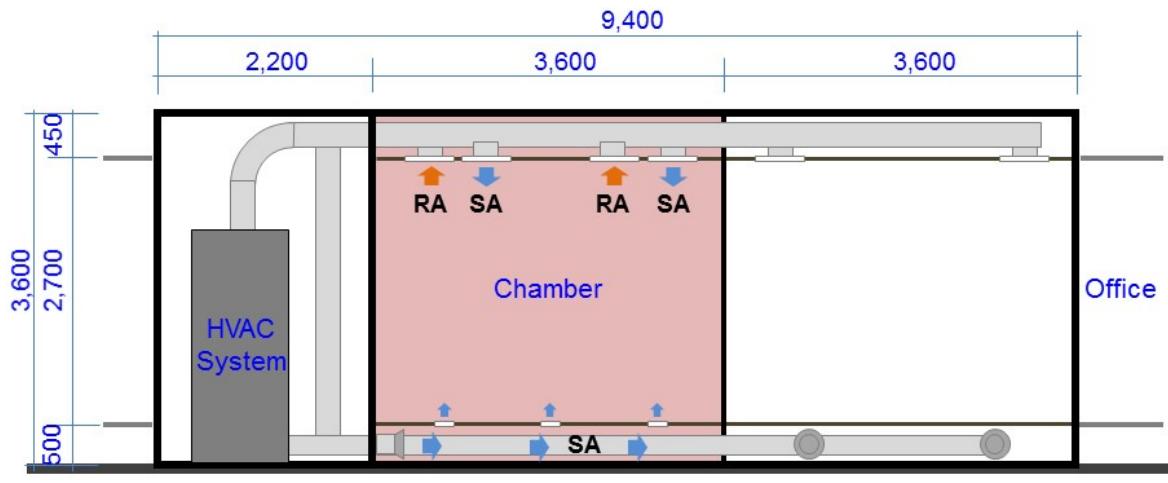
Figure 5. Section of the experimental chamber (unit: mm).